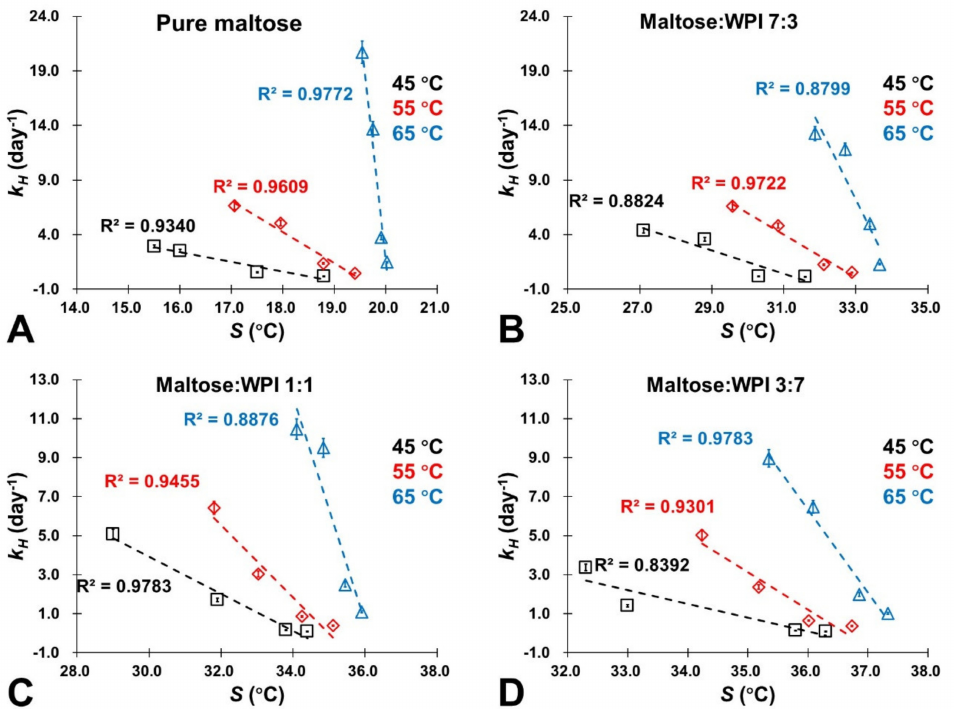
Figure 7. The relationship between the accumulation rate of 5-HMF ( k H ) of the studied samples based on the HPLC measurements and their corresponding S values calculated based on the literature